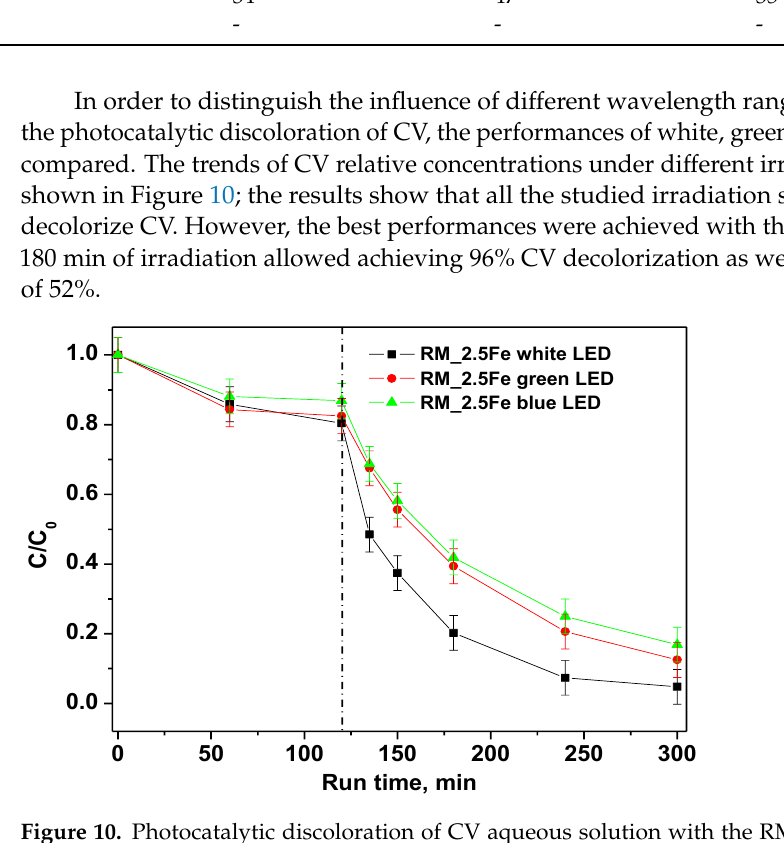
Figure 9. Photocatalytic discoloration of CV aqueous solution with all the studied photocatalysts under visible irradiation (white light).